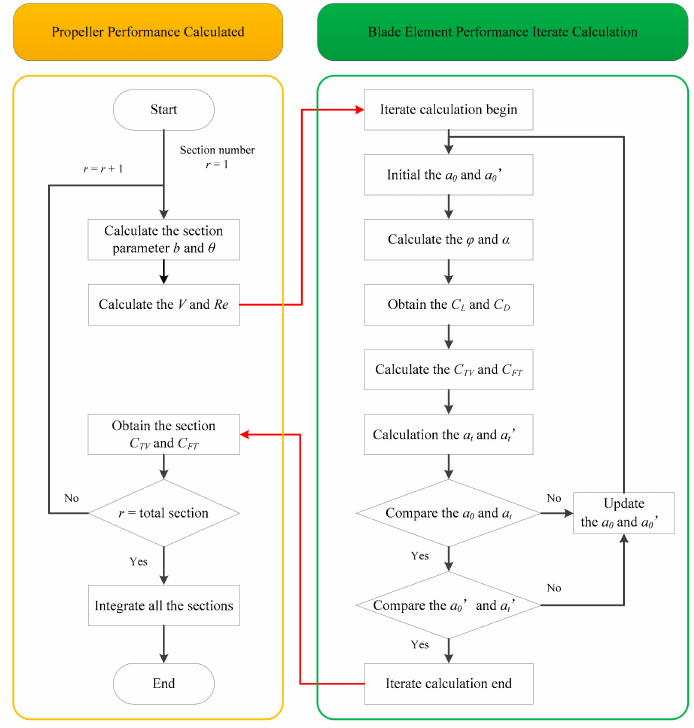
Figure 2. Iterative process for propeller performance